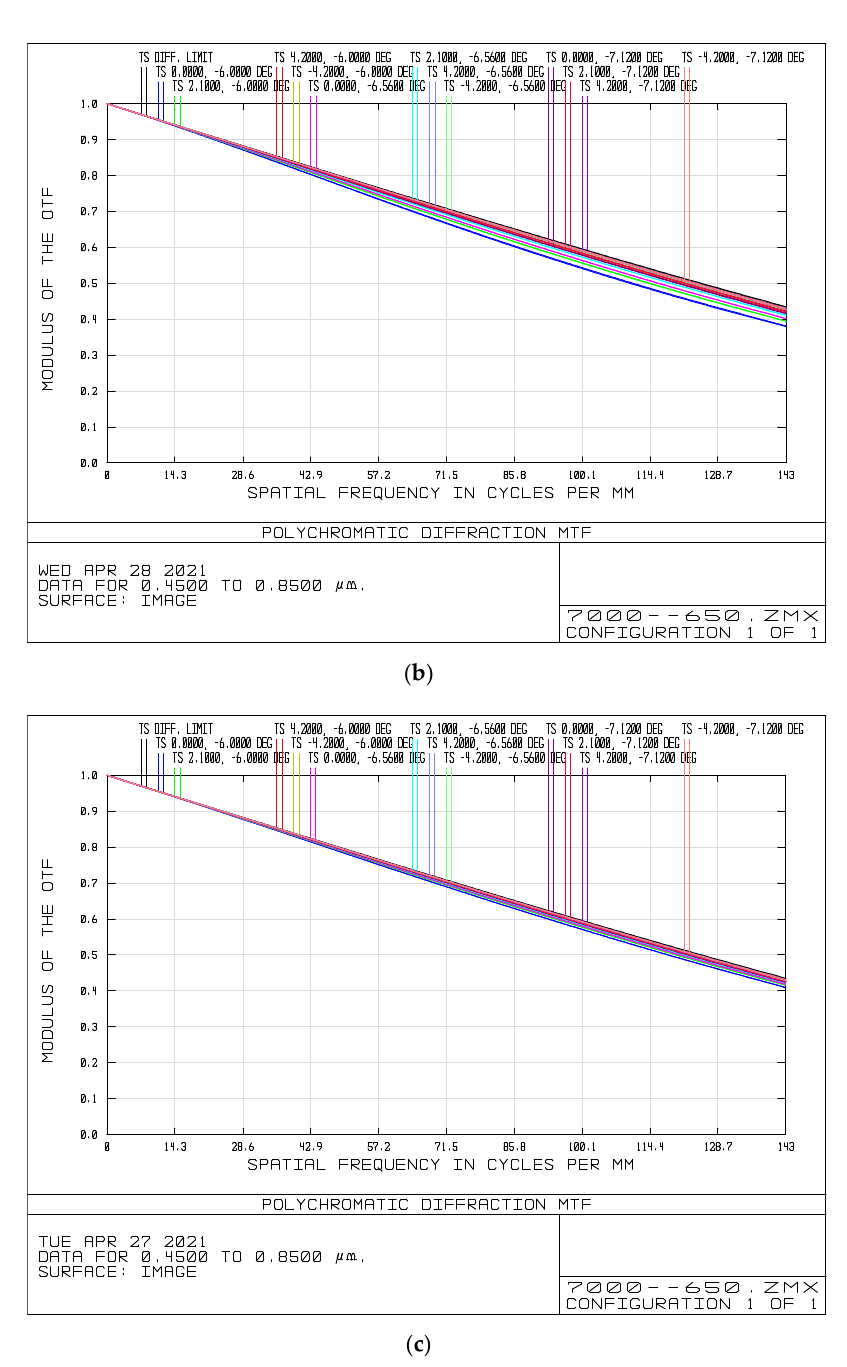
Figure 10. Comparison of MTF reduction of an optical system with two kinds of structures. ( a ) The- oretical MTF of the optical system; ( b ) MTF with the thermal deformation in an isotropic structure; ( c ) MTF with the thermal deformation in a zero-expansion structure. The analysis shows that when isotropic layers are used in the support structure, the MTF of the optical system decreases from 0.422 to 0.378 at a rise of 5 °C, and the decrease percentage is 10.43%. When the zero-expansion layers are used in the support structure, the MTF of the optical system decreases from 0.422 to 0.411 at a rise of 5 °C, and the de- crease percentage is 2.61%. The influence of the thermal deformation on the MTF of the optical transmission is greatly reduced. These results prove that the application of the